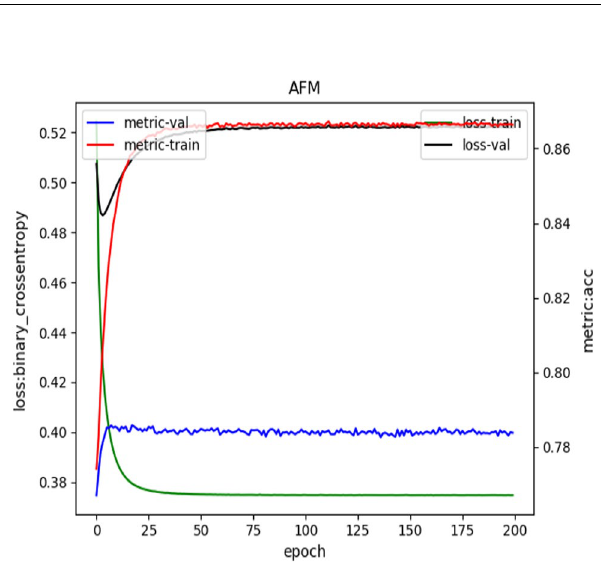
Fig. 6 AUC and Logloss of AFM algorithm